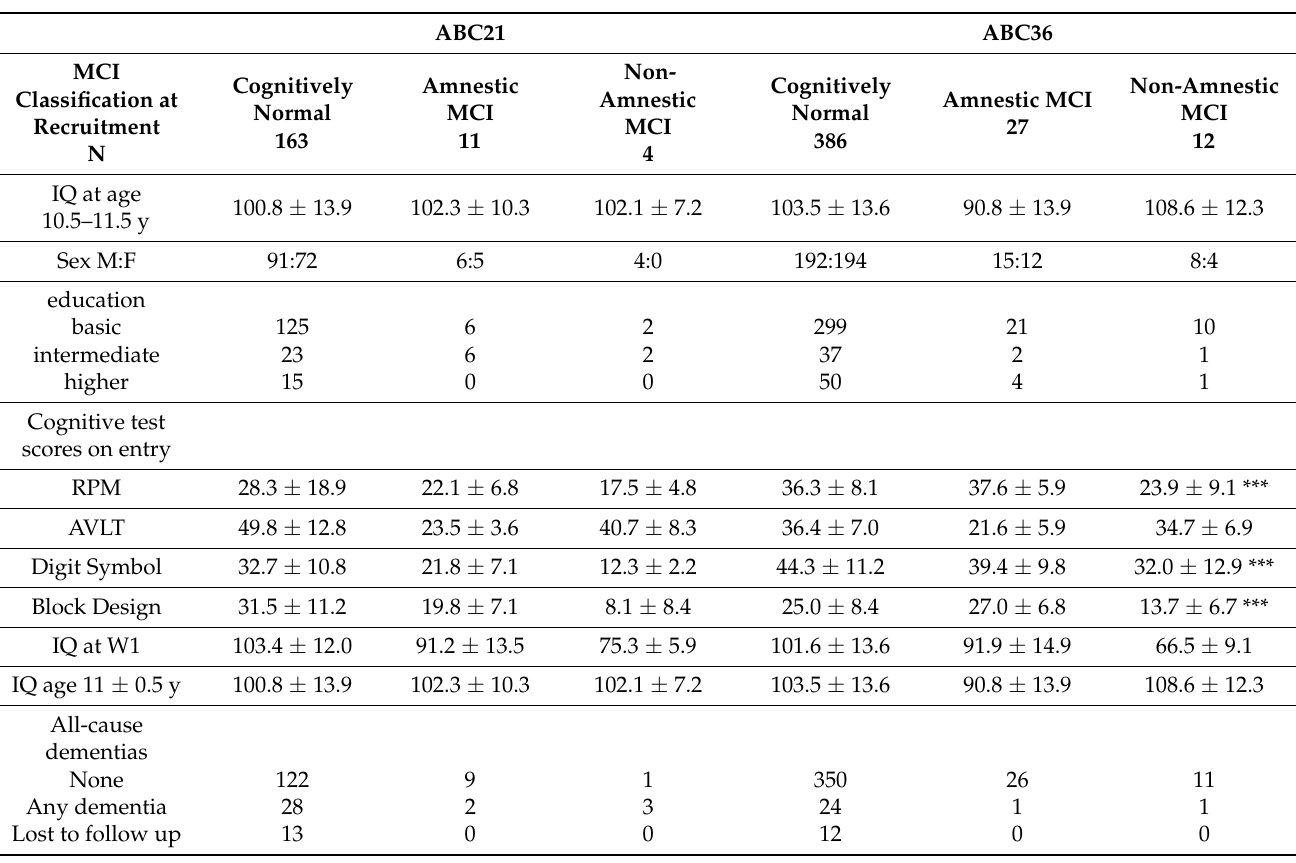
Table 3. Summary (means ± SD) sociodemographic and cognitive scores at study entry for the Aberdeen 1921 and 1936 birth cohorts classified by MCI status on recruitment at ages of about 64 y or 78 y. Participants were followed up from recruitment (1997–2001) up to 2014.